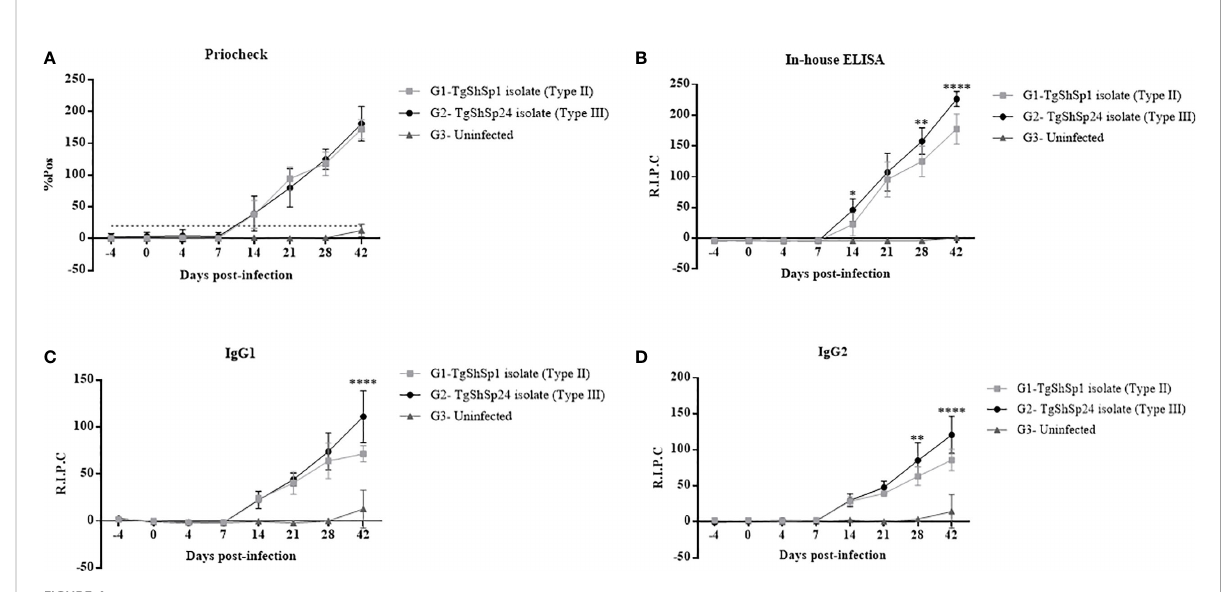
FIGURE 4 Evaluation of the IgG antibody levels by ELISA in sera from piglets infected with T. gondii oocysts from the TgShSp1 (G1) and TgShSp24 (G2) isolates and the non-infected group (G3). (A) Mean IgG levels by Priochek test are represented as the percentage of positivity (%PP). (B) Mean IgG levels by ELISA in house are represented as relative index percent (RIPC); (C) Mean RIPC IgG1 antibody levels; (D) Mean RIPC IgG2 antibody levels. Error bars represent SD. Signi fi cant differences between infected groups are indicated with asterisks, where *, ** and **** denote p < 0.05, p < 0.01 and p < 0.0001, respectively.